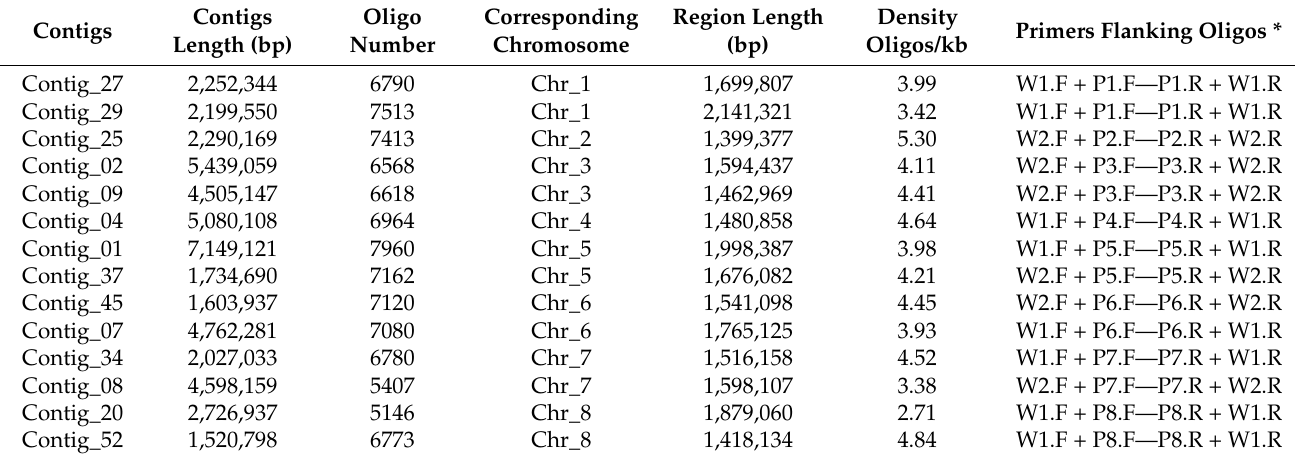
Figure 3. A model ideogram showing the locations of the single-copy oligo pool that produced the signals on the chromosomes of the Chinese cherry. Oligos were selected from 14 regions distributed on the pseudochromosome and colored red/green. The presence of six red and eight green regions showed that two different flanking external primer pairs could be amplified with their primers. The eight chromosomes could be distinguished based on the distribution pattern, i.e., the number and location of the red/green signals. Chromosome nomenclature followed pseudochromosomes in the draft genome of peach. The centromere positions on the eight chromosomes were determined based on the locations of centromere repeat sequences. Table 1. Numbers of oligos and contig positions of 14 regions selected for oligo-FISH probe development.